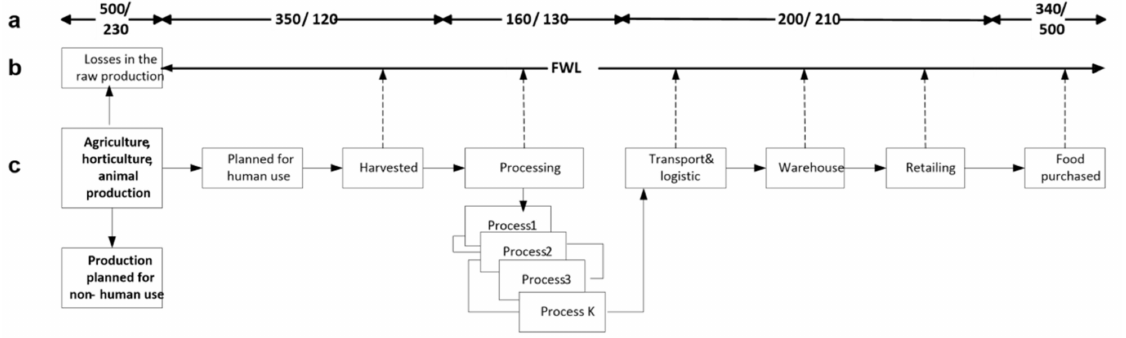
Figure 1. Value of economic food waste and loss (FWL) in the food system. Source: own compilation including data from Hegensholt et al. 2018 [45], where a—exemplary FWL in million tons/billion USD at different stages of production (Hegensholt et al. 2018 [45]); b—continuous FWL process; c—production